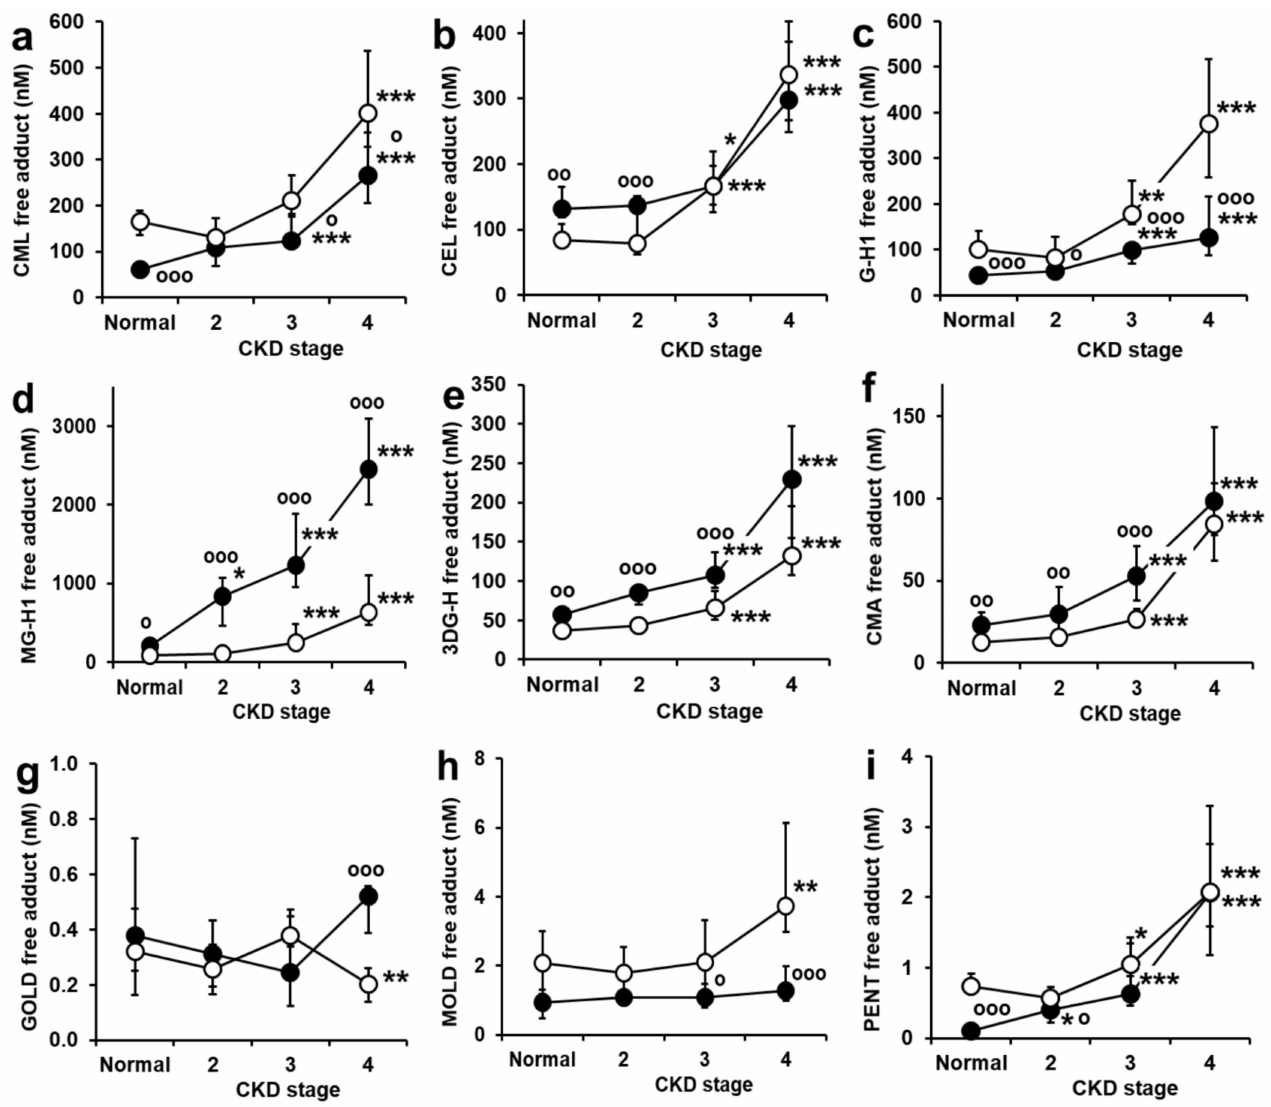
Figure 3. Serum AGE free adducts in subjects with normal renal function and stages 2–4 chronic kidney disease. ( a ) N ε -Carboxymethyl-lysine CML, ( b ) N ε -(1-Carboxyethyl)lysine CEL, ( c ) Glyoxal-derived hydroimidazolone G-H1, ( d ) Methylglyoxal-derived hydroimidazolone MG-H1, ( e ) 3-Deoxyglucosone-derived hydroimidazolone 3DG-H, ( f ) N ω -carboxymethylarginine CMA, ( g ) Glyoxal-derived lysine dimer GOLD, ( h ) Methylglyoxal-derived lysine dimer MOLD, , subjects without diabetes; • - • , subjects with diabetes. Data are median (lower–upper quartile), n = 7–29. Significance: *. ** and ***, p < 0.05, p < 0.01 and p < 0.001 with respect to subjects with normal renal function of the same diabetes status; and o and ooo, p < 0.05 and p < 0.001 with respect to subjects without diabetes of the same stage of CKD. Significance for 4 group comparison of normal renal function and stages 2–4 CKD, without and with diabetes ( Kruskal-Wallis ) were highly significant ( p < 0.001) except for GOLD and MOLD in subjects with diabetes ( p >